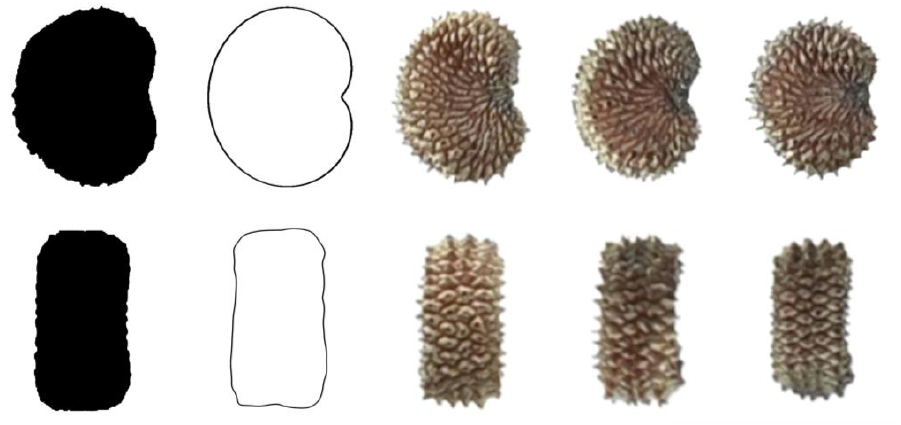
views. Bar represents 1 mm.